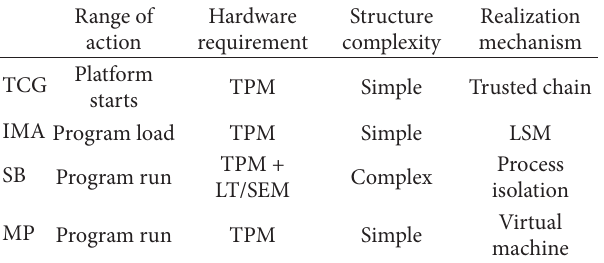
Table 1: Comparative analysis with other measurement models. Range